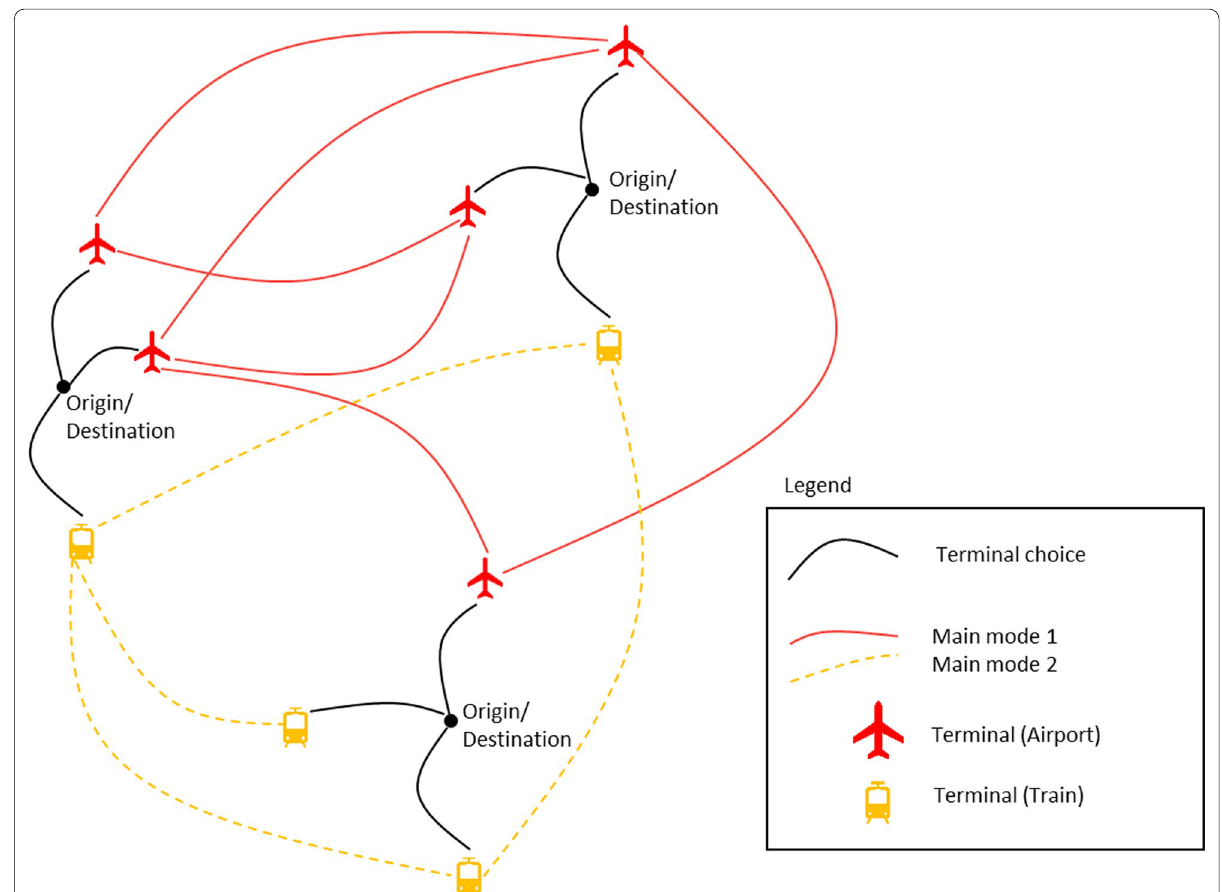
Fig. 8 Schematic figure of terminal choice within main mode and destination choice (Type